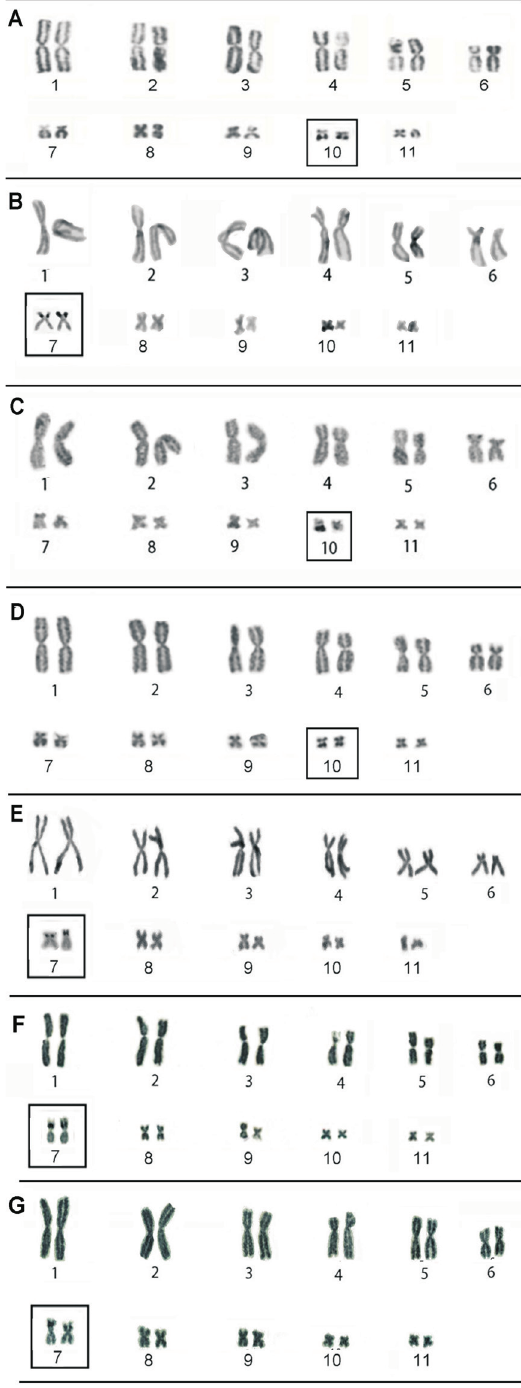
and Rhinella marina (F-G) groups from Brazil stained by the Ag-NOR method: (A) R. hoogmoedi ; (B) R. proboscidae ; (C) Rhinella sp. 1; (D) Rhinella sp. 2, and (E) Rhinella cf. margaritifera ; (F) R. ictarica, from Sertão, RS; (G) R. henseli, from Sertão, RS . The boxes indicate the NOR-bearing